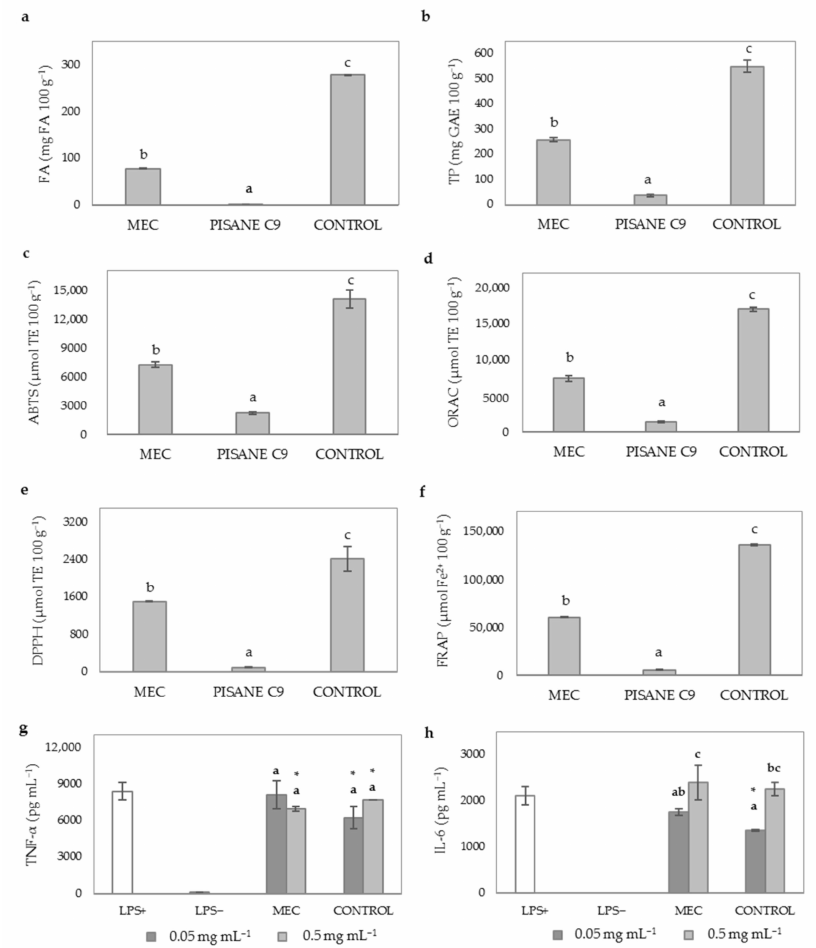
Figure 6. Evaluation of MEC on phenolic compounds content, TAC and AIA of WB hydrolysates. ( a ) FA content (mg 100 g − 1 ); ( b ) TP content (mg GAE 100 g − 1 ); ( c ) ABTS scavenging activity ( µ mol TE 100 g − 1 ); ( d ) ORAC ( µ mol TE 100 g − 1 ); ( e ) DPPH scavenging activity ( µ mol TE 100 g − 1 ); ( f ) FRAP ( µ mol Fe 2+ 100 g − 1 ); ( g ) TNF- α levels (pg mL − 1 ); ( h ) IL-6 levels (pg mL − 1 ). Sample identi- fication: hydrolyzed WB spray-dried at 130 ◦ C (CONTROL); pea protein (Pisane C 9 ); hydrolyzed WB microencapsulated with Pisane C 9 and spray dried at 130 ◦ C (MEC). Different lowercase letters show significant differences between samples (one-way ANOVA, post hoc Duncan’s test, p ≤ 0.05). * denotes significant differences between mean values of treatment groups and LPS+ cells (one-way ANOVA, post hoc Duncan’s test, p ≤ 0.05). Abbreviations: 2,2 (cid:48) -azino-bis (3-ethylbenzothiazoline- 6-sulfonic acid) (ABTS); 2,2-diphenyl-1-picryl-hydrazyl-hydrate (DPPH); ferulic acid (FA);